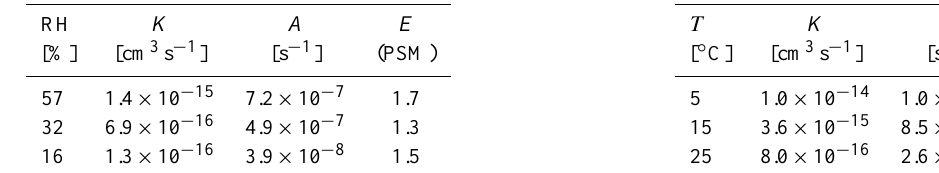
Table 5. Calculated median kinetic ( K) and activation ( A) coeffi- cients at different levels of relative humidity, exponent E is taken from the linear fit to PSM data of this study.